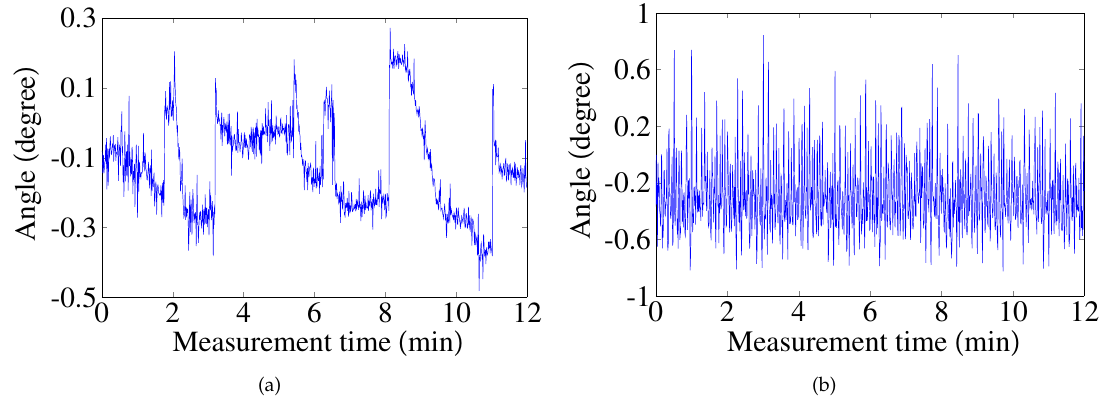
Figure 2. Laser beam pointing images captured by a beam profiler (BP100, Thorlabs., Newton, NJ, USA): ( a ) Green laser. λ = 520nm, and the power is 4.6mW; ( b ) Red laser. λ = 635nm, and the power is